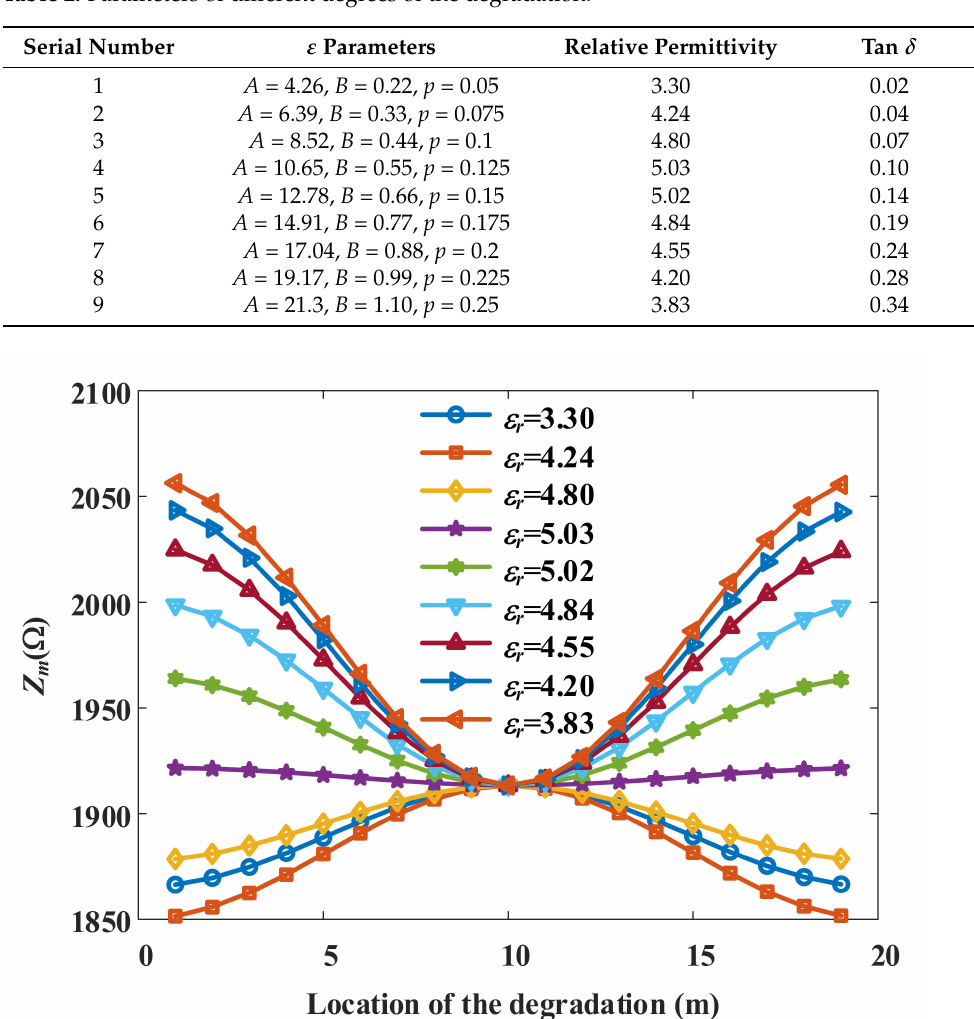
Table 2. Parameters of different degrees of the degradation.